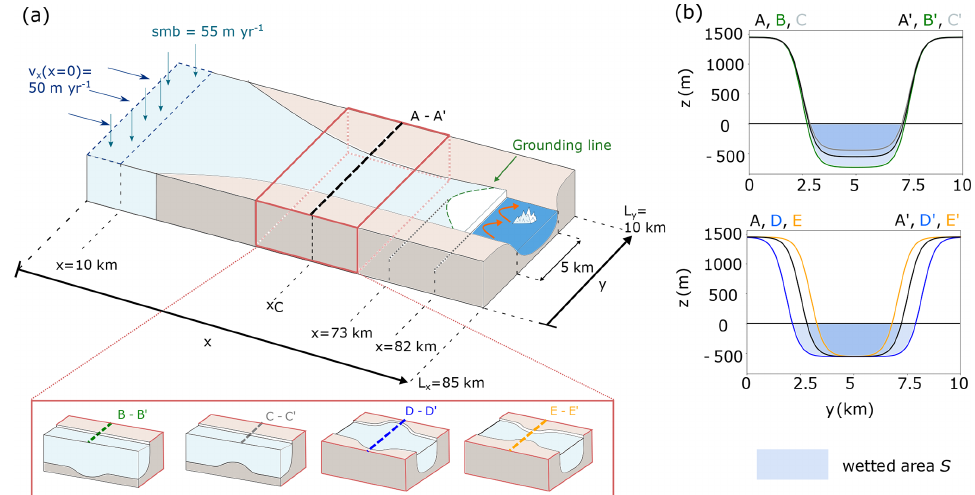
Figure 1. Schematic of the experimental setup. (a) Sketch of the domain (not to scale) with annotated dimensions and mass balance processes (gains: thickness-dependent influx and surface accumulation; losses: melt at the ice–ocean interface and calving). The red box symbolizes how the fjord geometry is changed in different experiments to include geometric perturbations (their center being referred to as x C ). (b) Cross- sections through the linear fjord (black line) and geometric perturbations. Upper panel: basal perturbations (green: depression; gray: bump); lower panel: lateral perturbations (blue: embayment; yellow: bottleneck). The wetted area, i.e., the cross-sectional area of the fjord below sea level, is shaded in blue for each geometry. Table 1. Parameters for generating fjord geometries (in parentheses for longer geometric perturbations).